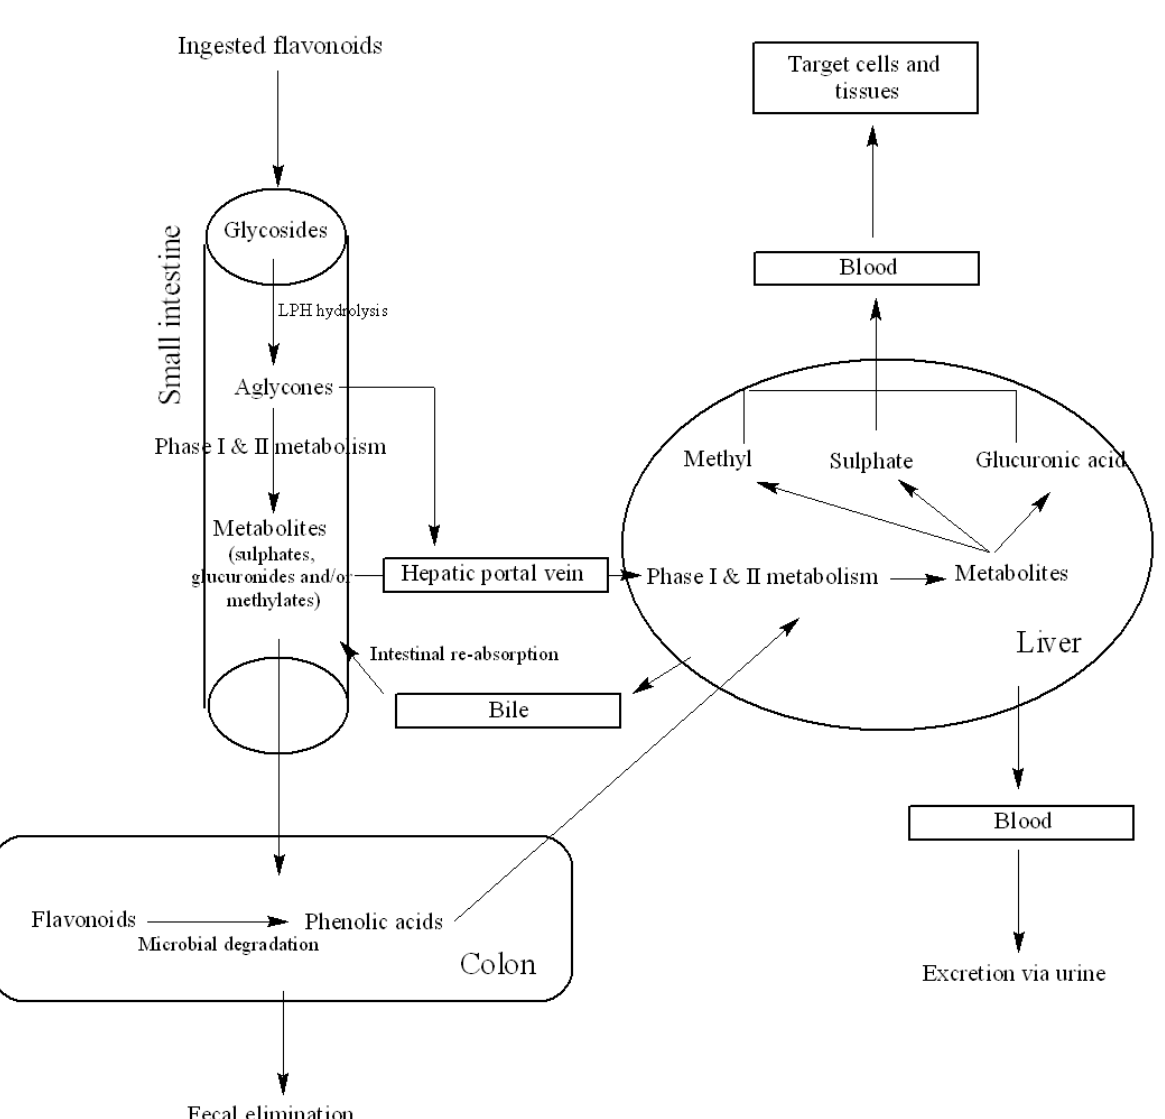
Figure 2. A simplified schematic of human flavonoid metabolism. Ingested flavonoids undergo extensive intestinal metabolism. Metabolites are then transported to the liver via hepatic portal vein and undergo further metabolism. The liver metabolites can be transported to targeted cells and tissues, excreted to bile and undergo enterohepatic re-circulation, or eliminated via urine and/or feces. The aglycones or flavonoid metabolites that reach the colon can undergo microbial degradation and reabsorption (LPH: lactase-phlorizin hydrolase; adapted from [43] with